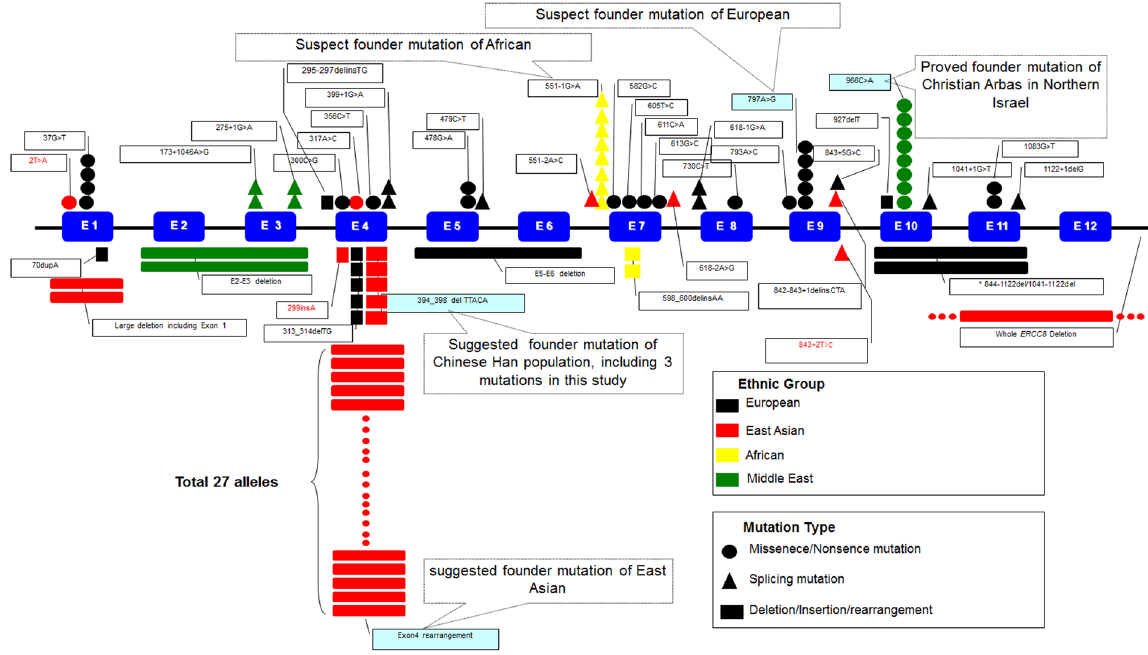
Figure 4. Summary of the identified mutational spectrums of ERCC8 in different populations showing the types and numbers of each mutation in all ethnic backgrounds of ERCC8 . Note that there are different spectrums of ERCC8 mutations in different ethnic backgrounds. The exon 4 rearrangement mutation is a hot- spot mutation in East Asians derived from a common founder mutation (red box). The c.394_398delTTACA mutation was the second-most frequent mutation found specifically in Chinese patients with CS-A. Red word: Three novel mutations in this